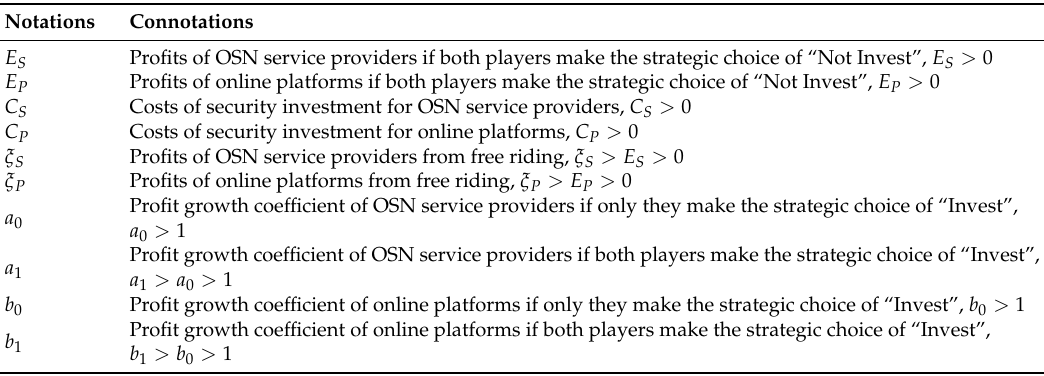
Table 2. Key notations of the evolutionary game